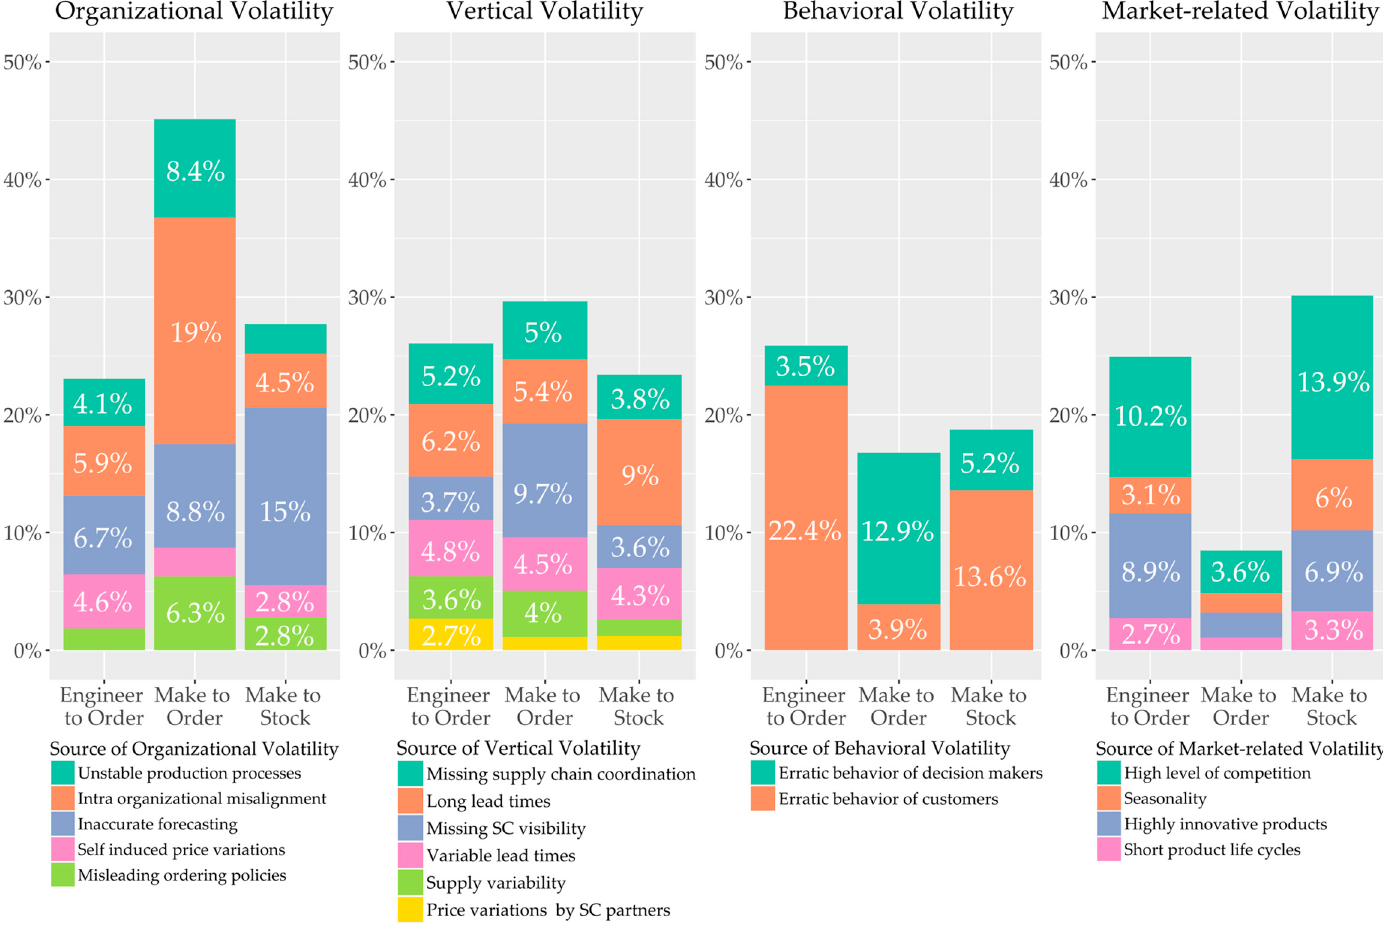
Figure 6. Impact of SCV sources on SCV analyzed by production strategy.